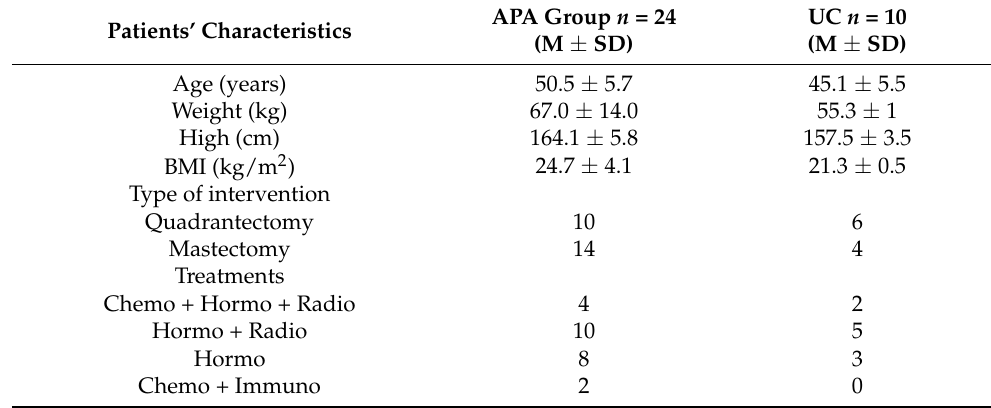
Table 3. Patients’ characteristics. Abbreviation: APA = Adapted Physical Activity; UC = Usual Care M = mean; SD = Standard Deviation; n = numbers; BMI = Body Mass Index; Chemo = Chemotherapy; Hormo = Hormonal therapy; Radio = Radiotherapy; Immuno = Immunological